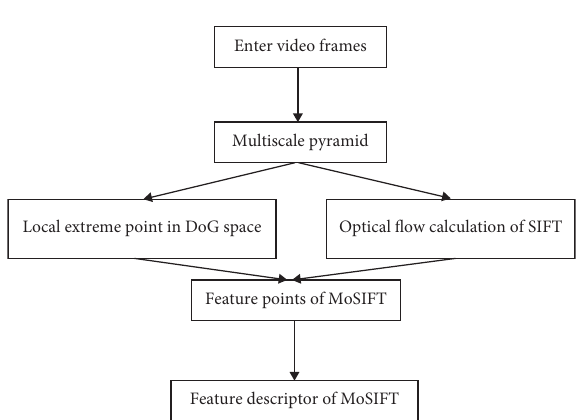
Figure 2: The flow chart of the MoSIFT